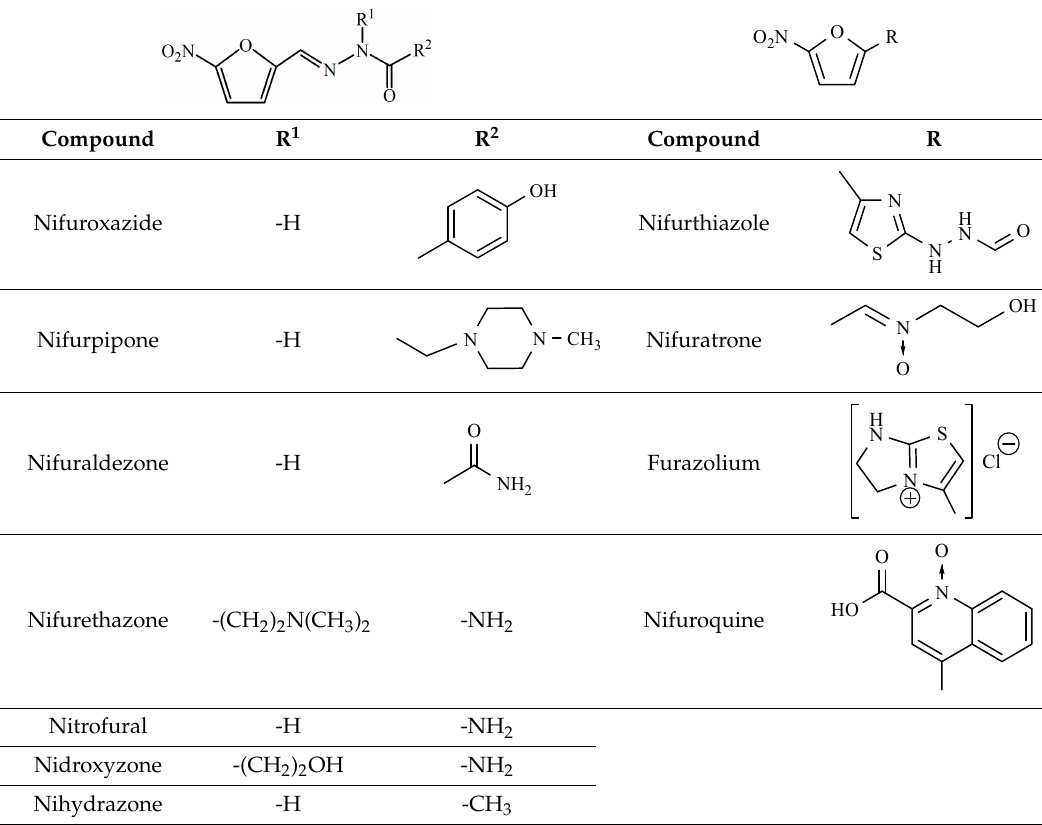
Table 5. Antiprotozoal 5-nitrothiazole Table 5. Antiprotozoal 5-nitrothiazole derivatives. Table 5. Antiprotozoal 5-nitrothiazole derivatives. Table 5. Antiprotozoal 5-nitrothiazole derivatives. Table 5. Antiprotozoal 5-nitrothiazole derivatives. Table 5. Antiprotozoal 5-nitrothiazole derivatives. Table 5. Antiprotozoal 5-nitrothiazole derivatives. Table 5. Antiprotozoal 5-nitrothiazole derivatives. Table 5. Antiprotozoal 5-nitrothiazole derivatives.